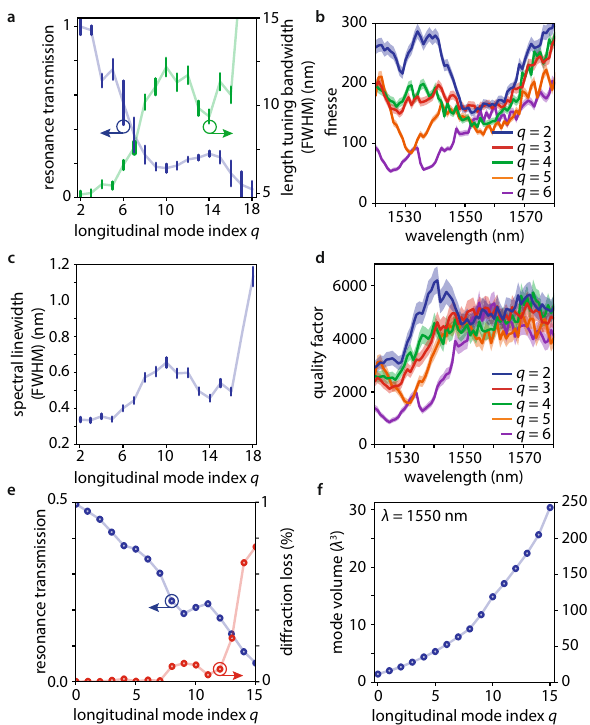
Fig. 4 | Properties of the metasurface-stabilized optical microcavity. a measuredlongitudinalmodeindex q -dependentrelativetransmission(bluelines, i.e., the heights of the resonance peaks in Fig. 3e) and length tuning bandwidth (green lines, full width at half maximum (FWHM), i.e., the width of the resonance peak indicated by the black arrows in Fig. 3f) of the metasurface-stabilized trans- verse fundamental cavity modes. The error bars denote standard deviations cal- culated from the resonance fi t and the measured piezo nonlinearity. b measured longitudinal mode index- and wavelength-dependent fi nesse of the metasurface- stabilized transverse fundamental cavity modes (colored lines). Shaded areas denote standard deviations calculated from the resonance fi t and the measured piezo nonlinearity. c measured longitudinal mode index-dependent spectral line- width (blue lines), of the metasurface-stabilized transverse fundamental mode cavity modes. The error bars denote standard deviations calculated from the resonance fi tandthemeasurednonlinearityofthepiezoelectricstage. d measured longitudinal mode index- and wavelength-dependent quality factor of the metasurface-stabilized cavity modes with n + m =0 (colored lines). Shaded areas denote standard deviations calculated from the resonance fi t and the measured nonlinearity of the piezoelectric stage. e calculated longitudinal mode index- dependent resonance transmission (blue dots and line, i.e., the evolution of the resonance peak heights in Fig. 2a) and the round-trip diffraction losses (red dots and line) for the optimal design in Fig. 1i. f fi nite difference time domain modeling of the longitudinal mode index-dependent mode volumes (blue dots and line) for the metasurface-stabilized microcavity using the optimal design in Fig. 1i. The mode volume is measured relative to the wavelength λ